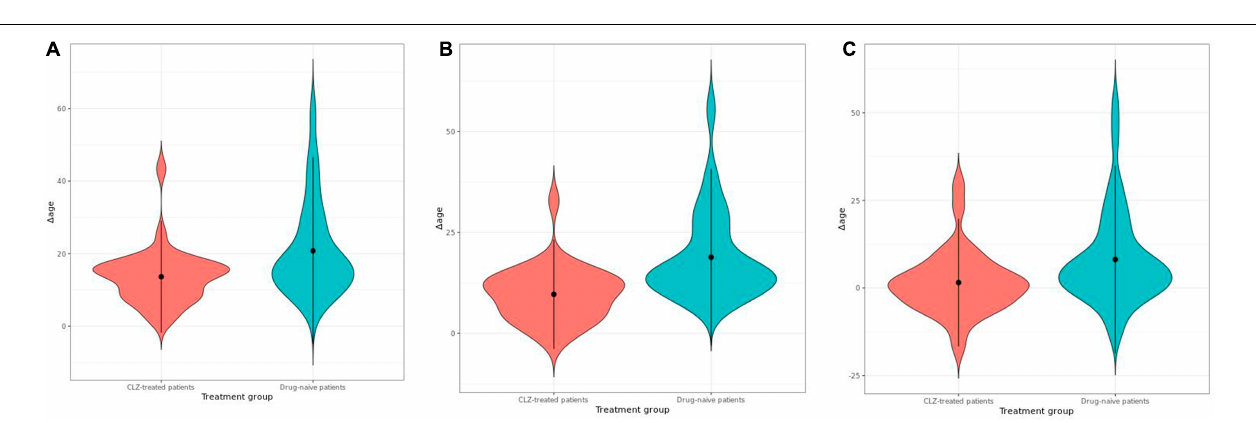
FIGURE 2 | Violin plots showing the comparison of (cid:49) age between clozapine (CLZ)-treated patients and drug-naive patients estimated by using epigenetic clocks of (A) Horvath, (B) Hannum, and (C) PhenoAge.